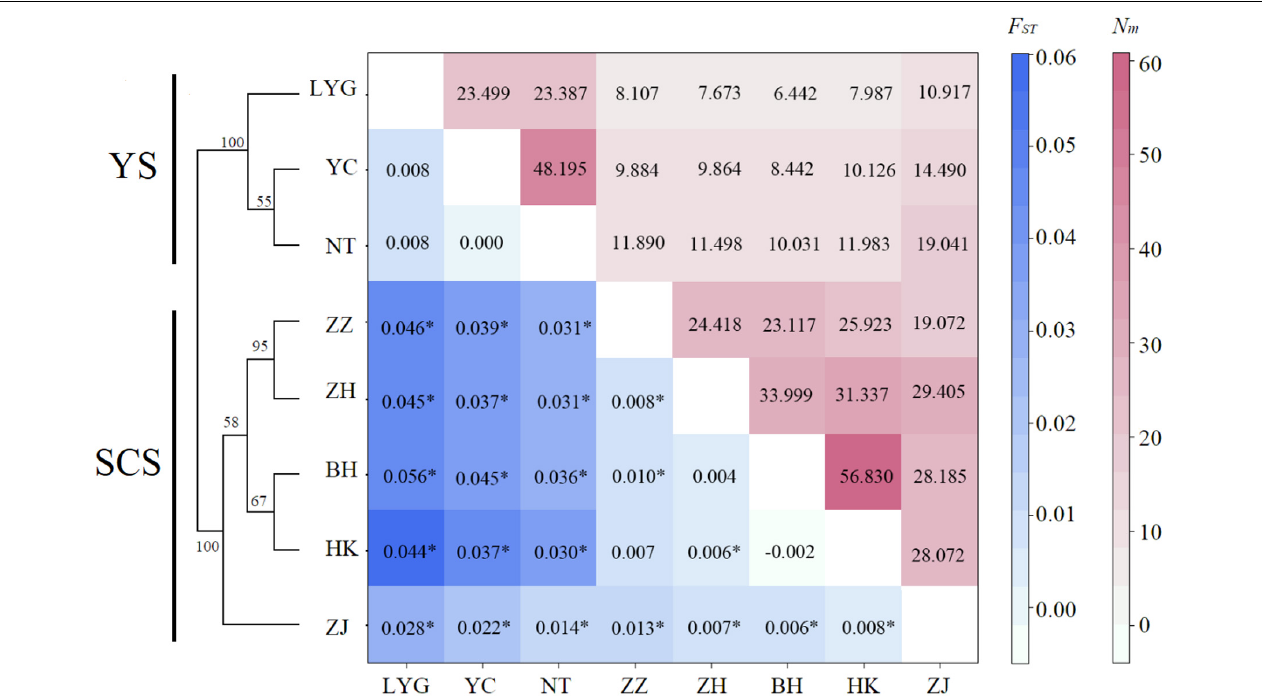
FIGURE 2 | Matrix showing pairwise differentiation estimates ( F ST ) between eight M. meretrix samples based on six microsatellite loci (below the diagonal), and estimated number of migrants per generation ( N m ) among samples (above the diagonal). Values with * indicate statistical significant difference from zero ( P < 0.002, P -values adjusted for multiple comparisons using Bonferroni correction = 0.05/28). Neighbor-joining dendrogram based on Cavalli-Sforza and Edwards’ genetic distance ( D C ) values among eight M. meretrix samples from Chinese coastal areas based on six microsatellite loci Bootstrap values supporting each node indicate the percentage of phylogenetic tree sharing that node among 1,000 bootstrap replicates.